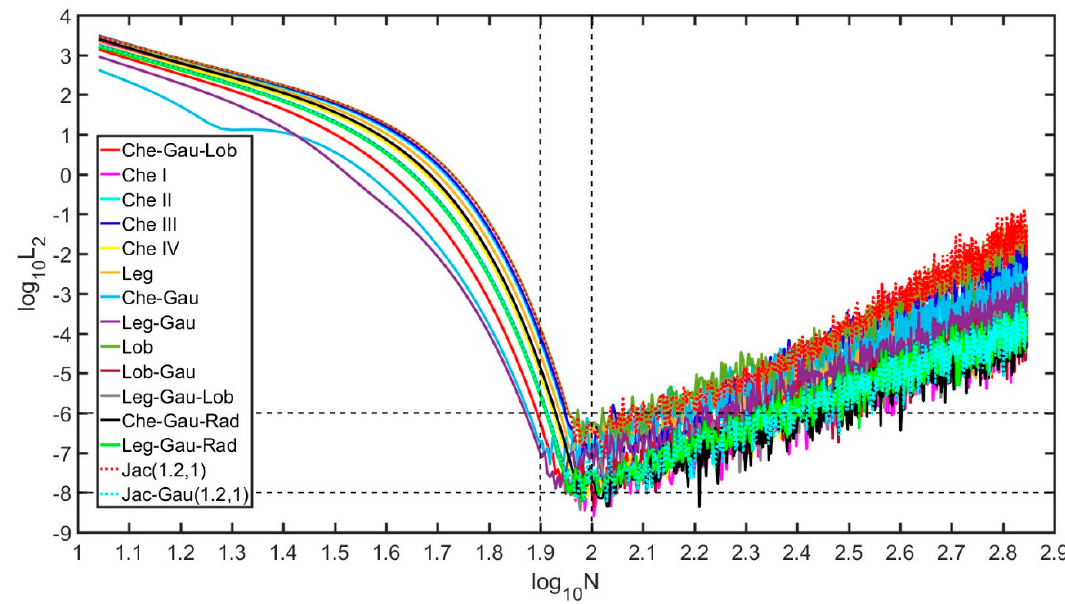
L error norm of the traction vector at the interface for varying grid distributions. Figure 2. Figure 2. L 2 error norm of the traction vector at the interface for varying grid 2